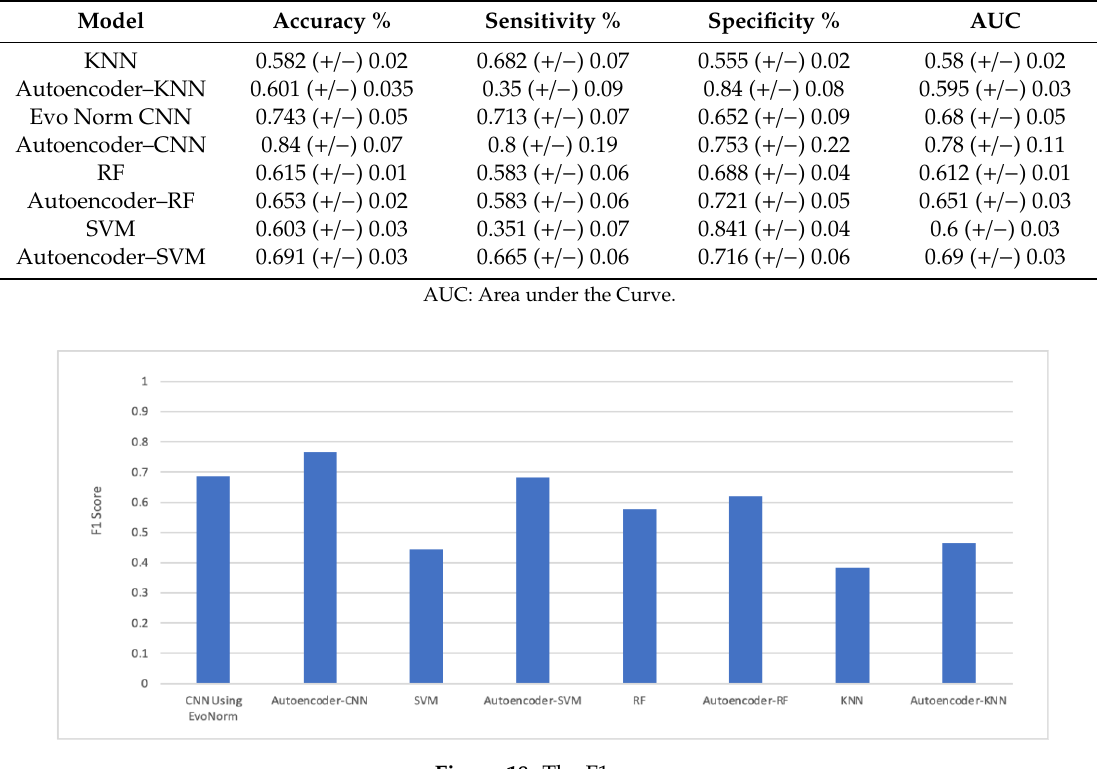
Figure 17. ROC curve and AUC values for autoencoder–KNN ( Left ) and KNN ( Right ).